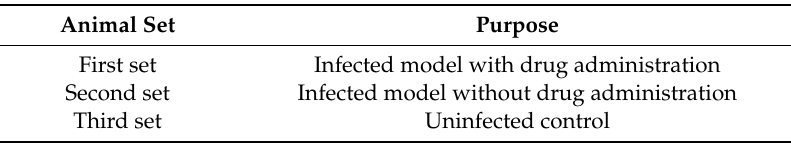
Table 1. Animal set